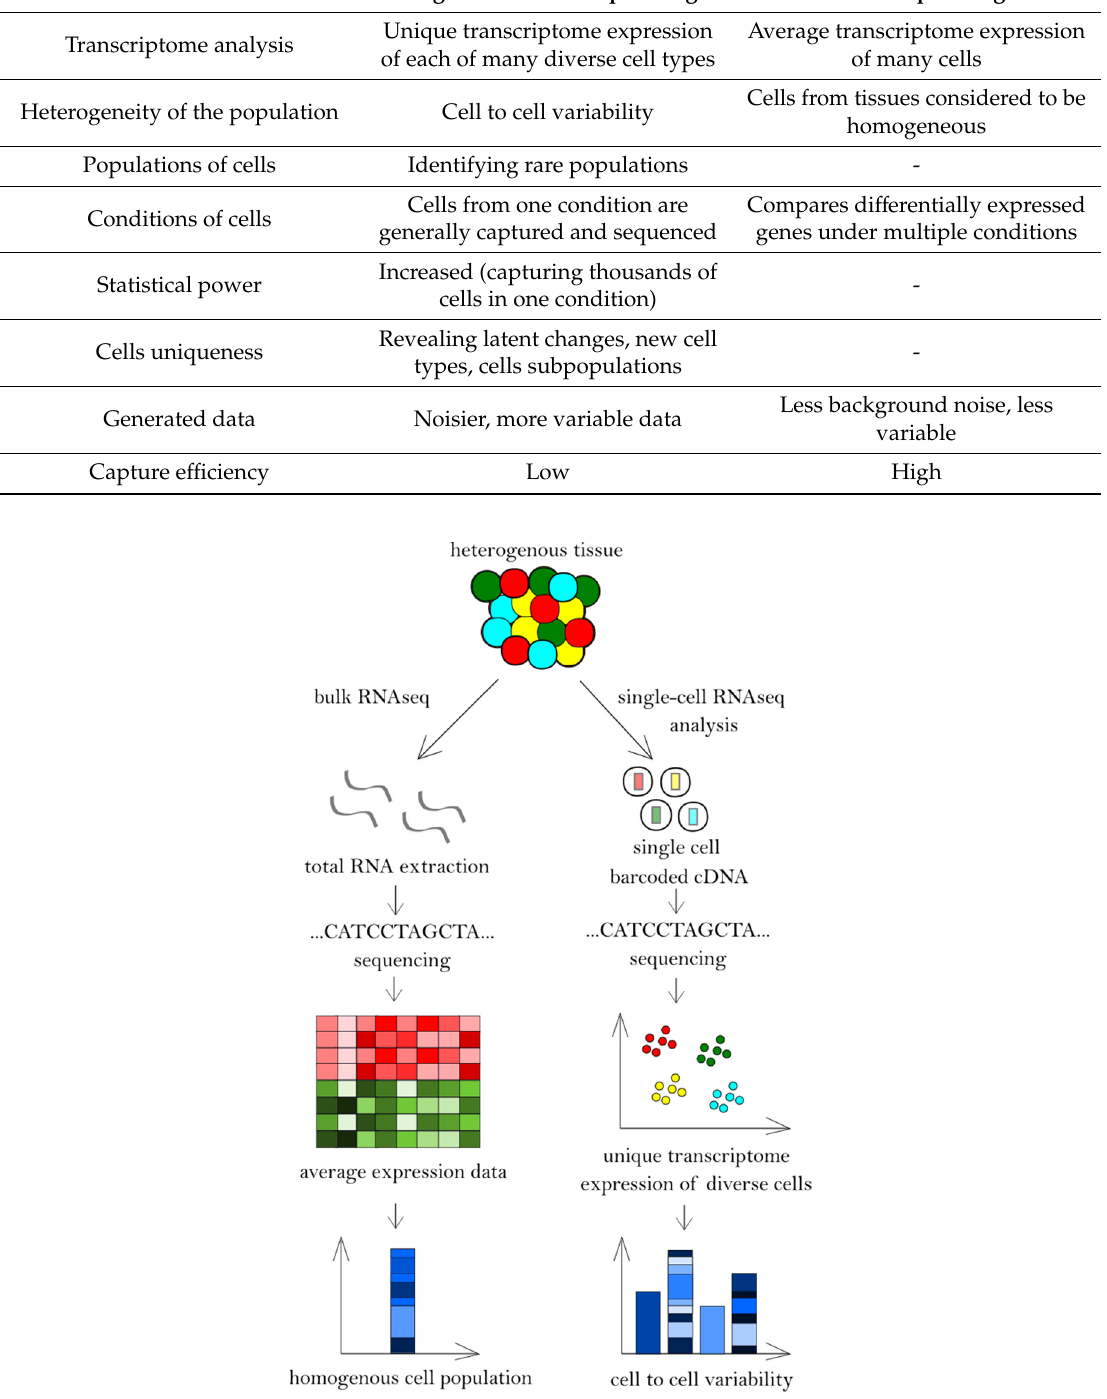
Figure 1 . Bulk RNA sequencing and single-cell RNA sequencing workflow. Figure 1. Bulk RNA sequencing and single-cell RNA sequencing